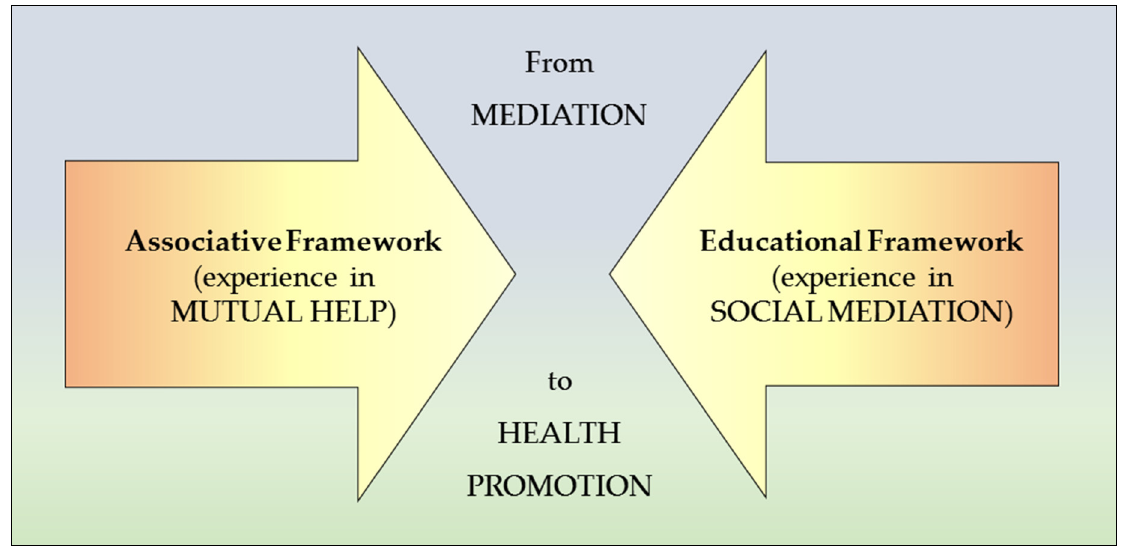
Figure 2. Confluence of systems for health promotion.